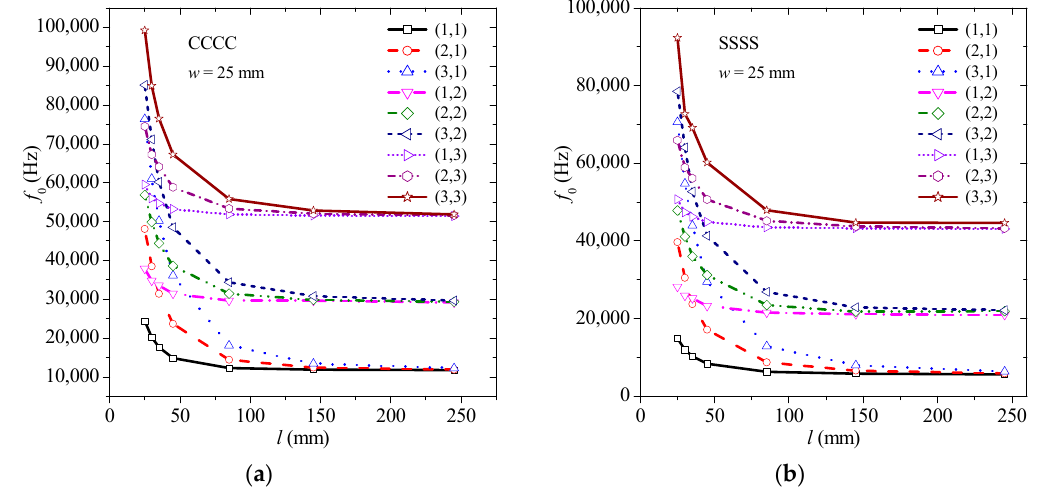
Figure 3. Natural frequency of the composite plate without the presence of graphene considering various configurations for ( a ) CCCC, and ( b ) SSSS boundary conditions.